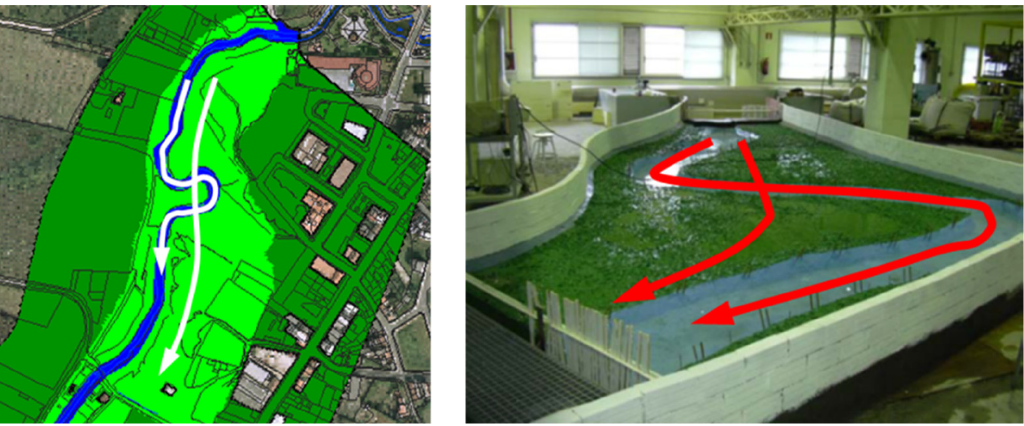
Figure 1. Streamlines during low and high flows in meandering rivers.